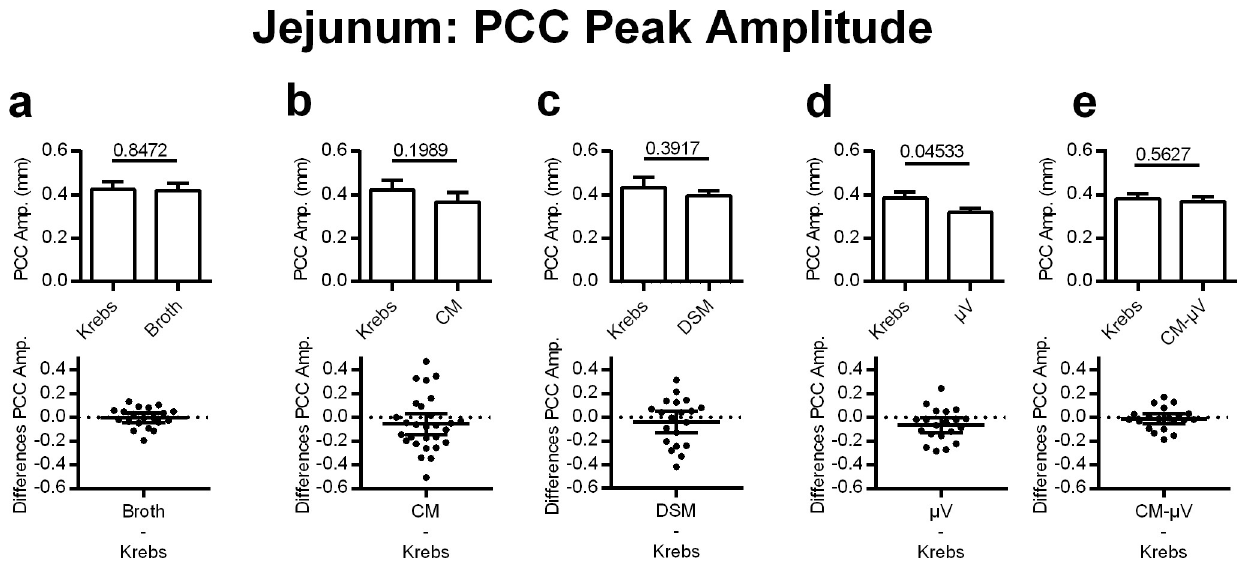
Fig 4. Effects of adding DSM, μ V or media on PCC peak amplitude for mouse jejunal segments, in vitro . d) μ V (N = 20) but not a) broth (N = 20), b) CM (N = 28), c) DSM (N = 20), or e) CM- μ V (N = 20) reduced PCC amplitude. P values derived from paired t-tests are given above horizontal bars. Significance determined when p < 0.05.